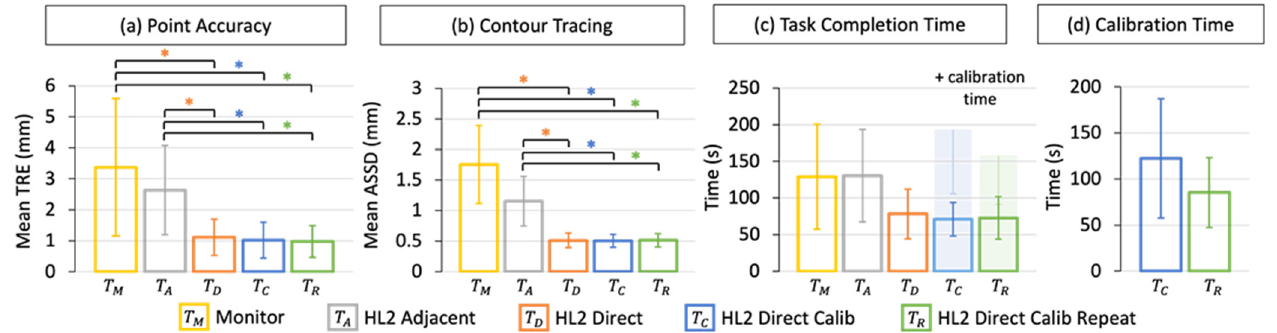
Figure 5. Quantitative results of the user-study. ( a ) Point accuracy was assessed as the mean target registration error (TRE), in millimeters, between user-points and ground truth points. ( b ) Contour tracing was measured as the average symmetric surface distance (ASSD), in millimeters, between the user and ground truth trace. ( c ) Task completion time and ( d ) per-user manual display calibration time were measured in seconds. HoloLens 2 (HL2) tasks are labelled. Significant results ( 𝑝 < 0.05 ) are indicated by an Asterix (*).